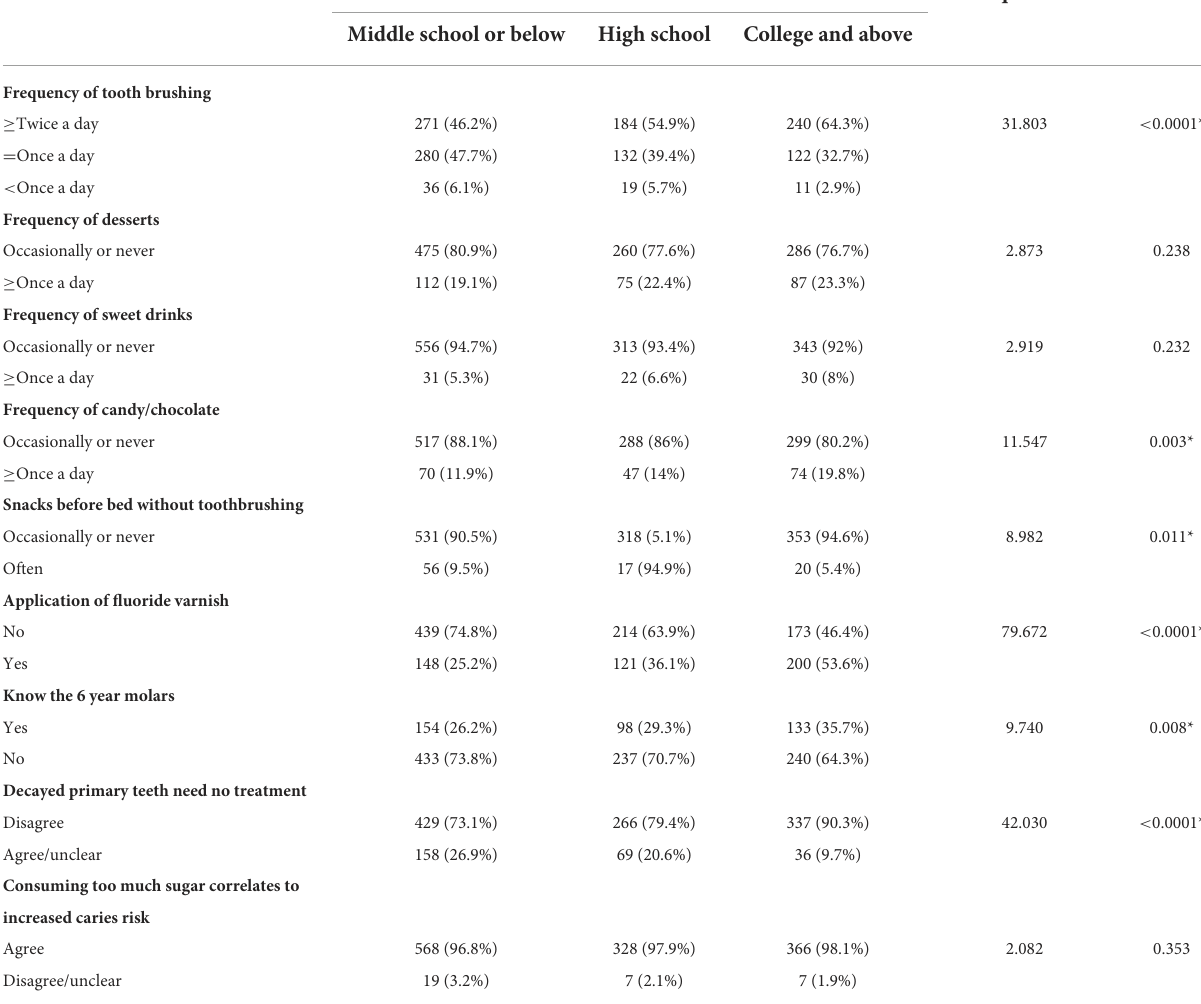
TABLE 5 Parental education level and different variables ( N =